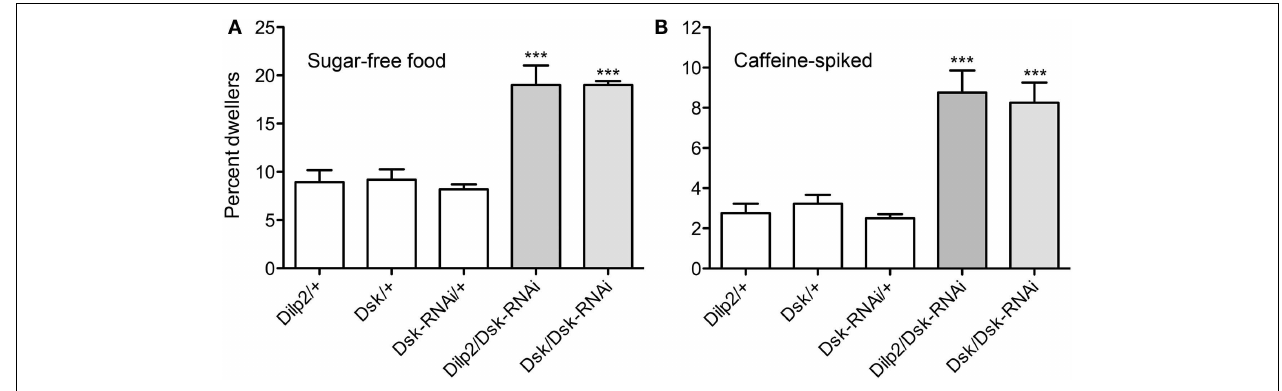
remained in the sugar-free food to a higher extent than controls (white bars). Results are given as percent dwellers, i.e., larvae remaining in non-preferred food. (B) Test of same genotypes on caffeine-spiked food. Again, knockdown of Dsk in either IPCs or DPCs resulted in larvae that were more likely to dwell in the caffeine-spiked rather than moving to the standard